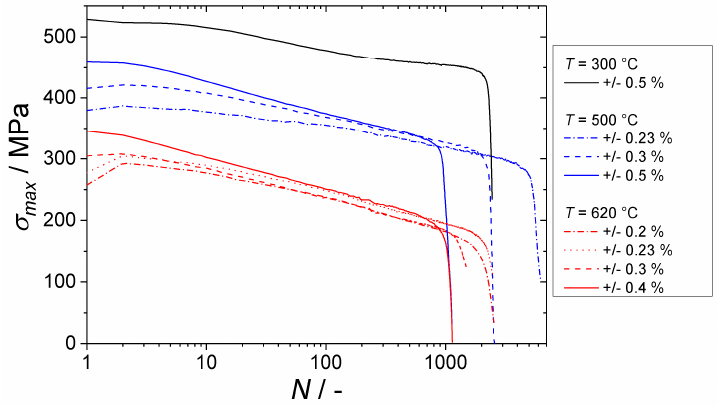
Figure 11. Cyclic stress response curves for the different RF-tests with tensile and compressive holds of 3 min.